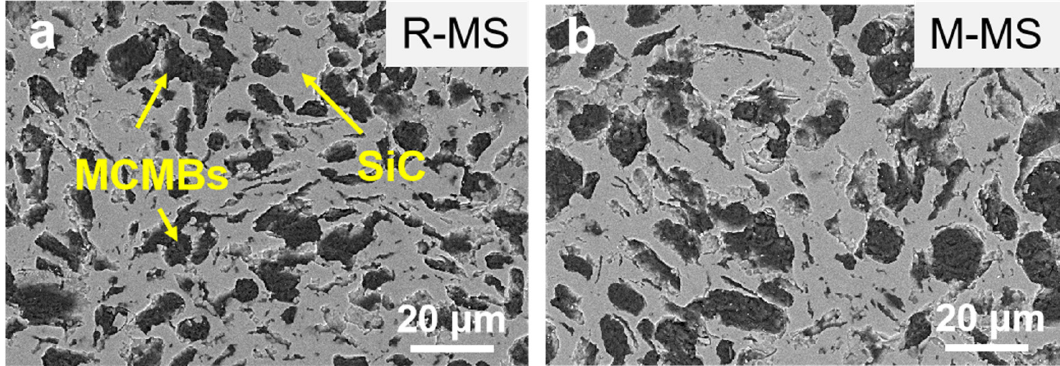
Figure 4. SEM images of polished surface of MCMB-SiC composites: ( a ) R-MS; ( b ) M-MS.